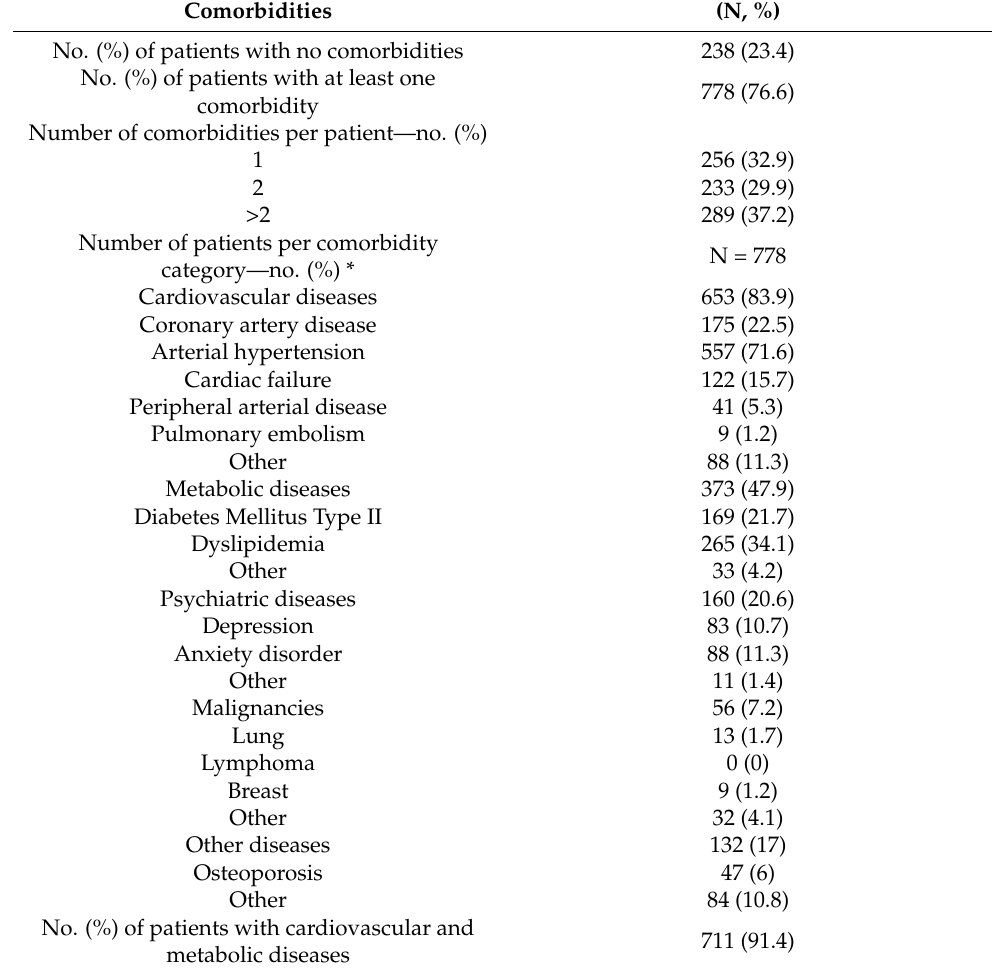
Table 2. Comorbidities of participants in the